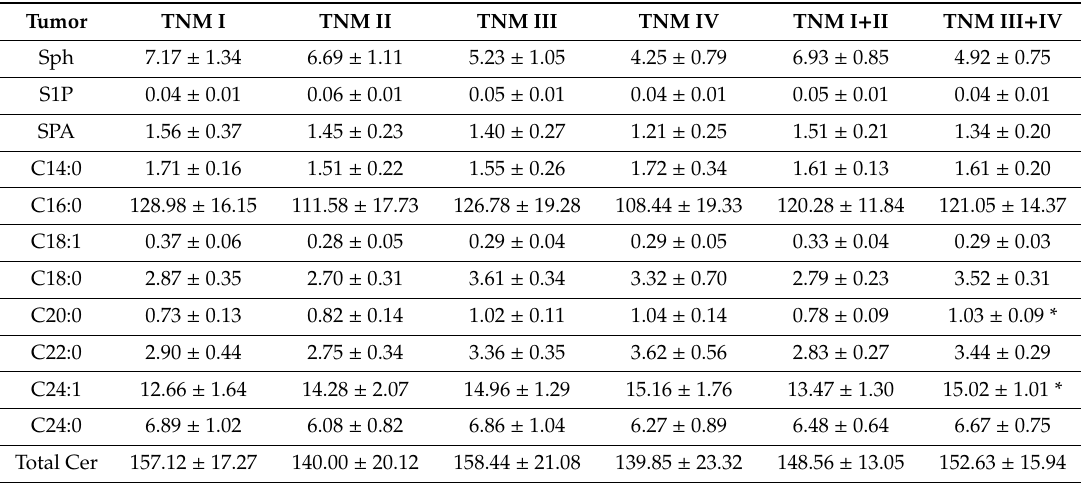
Table 3. Content of sphingolipids in colorectal cancer tissue of patients divided into groups depending on the 8th edition of the TNM